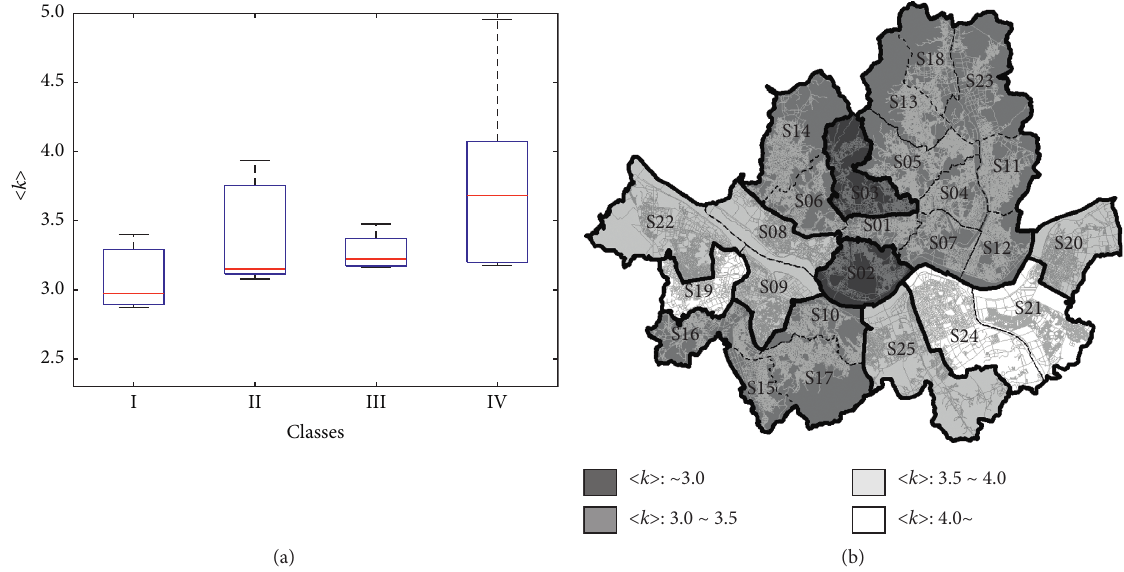
Figure 2: (a) Statistics of < k > values for each road history class and (b) twenty-five districts in Seoul re-classified by the < k >